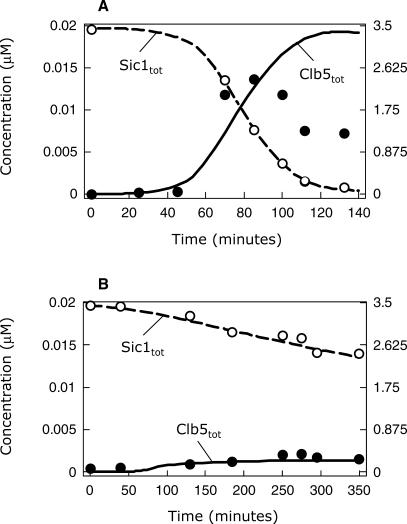
Comparison of Experimental Data and Simulation Results for Total Sic1 and Clb5Experimental protein levels, indicated as white (Sic1) and black (Clb5) dots, were determined for elutriated wild-type cells grown in glucose medium (A) or ethanol medium (B). For further explanation, see text.